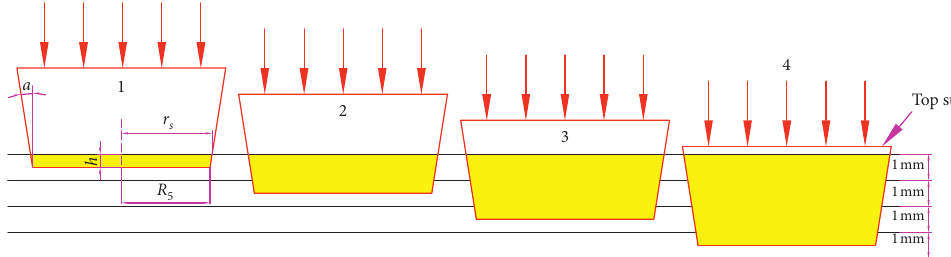
Figure 6: Distributions of the volumetric heat flux in the pin-plunging stage at different steps in the